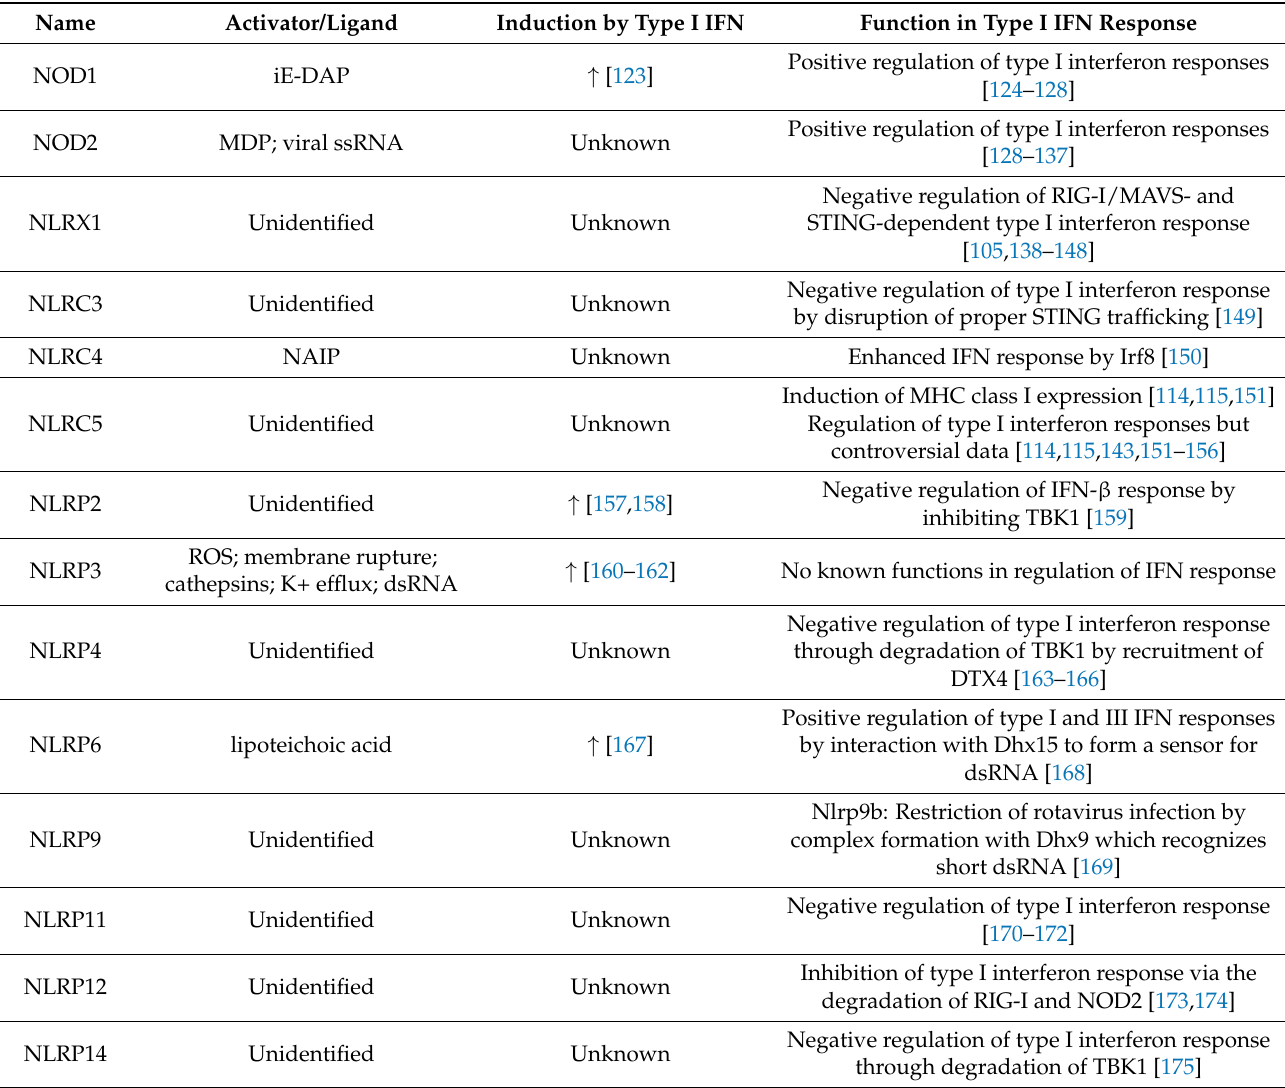
Table 1. Role of Nod-like receptors (NLRs) in interferon responses. The upward arrow indicates